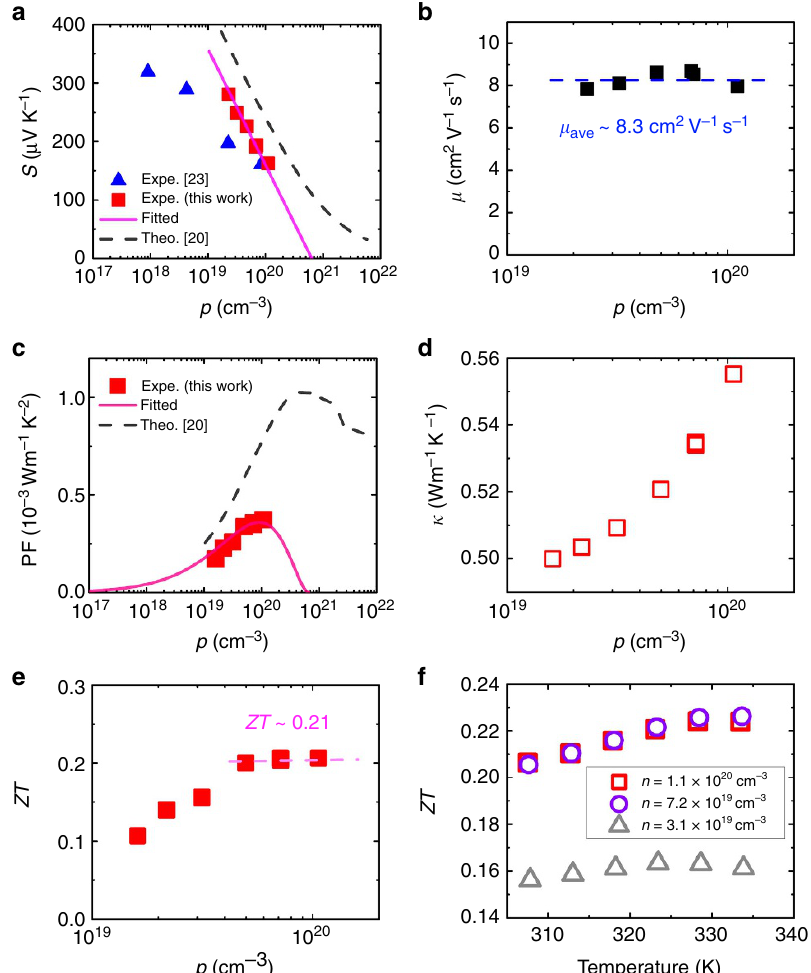
Figure 1 | Thermoelectric properties of the p-type CuI thin films. ( a ) Seebeck coefficients S , ( b ) hole mobility m , ( c ) power factor PF, ( d ) thermal conductivity k and ( e ) figure-of-merit ZT of g -CuI thin films (thickness of 300nm) deposited on glass as a function of hole concentration p at 300K. ( f ) Figure-of-merit ZT of g -CuI thin films deposited on glass near room temperature. In a the solid line is a fit with equation (4). In b and e the dashed line is a guide to eye indicating the averaged hole mobility m ave or the saturation of ZT. In ( c ) the solid line is derived from the calculation using equation (6) with a single-band model, and the dashed line presents the theoretical data taking into account the non-parabolicity of the bands.